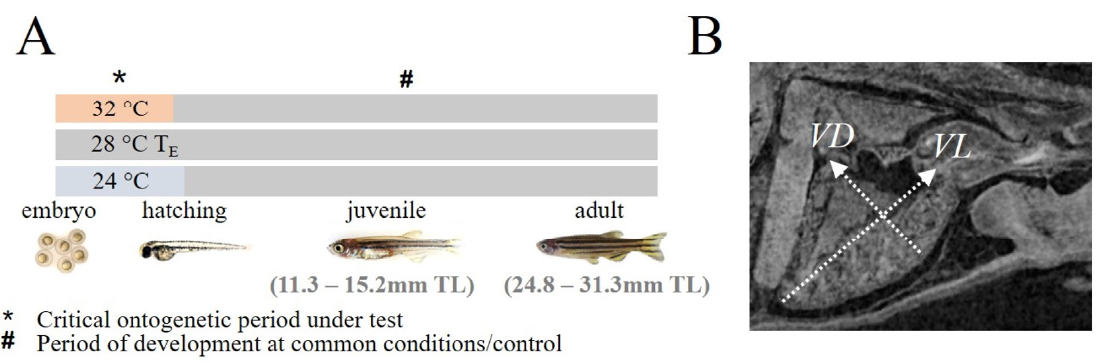
Figure 1. ( A ) Experimental design of the study, ( B ) Representative cross-section of the heart. T E = embryonic temperature; TL = total length; VD = ventricle depth; VL = ventricle